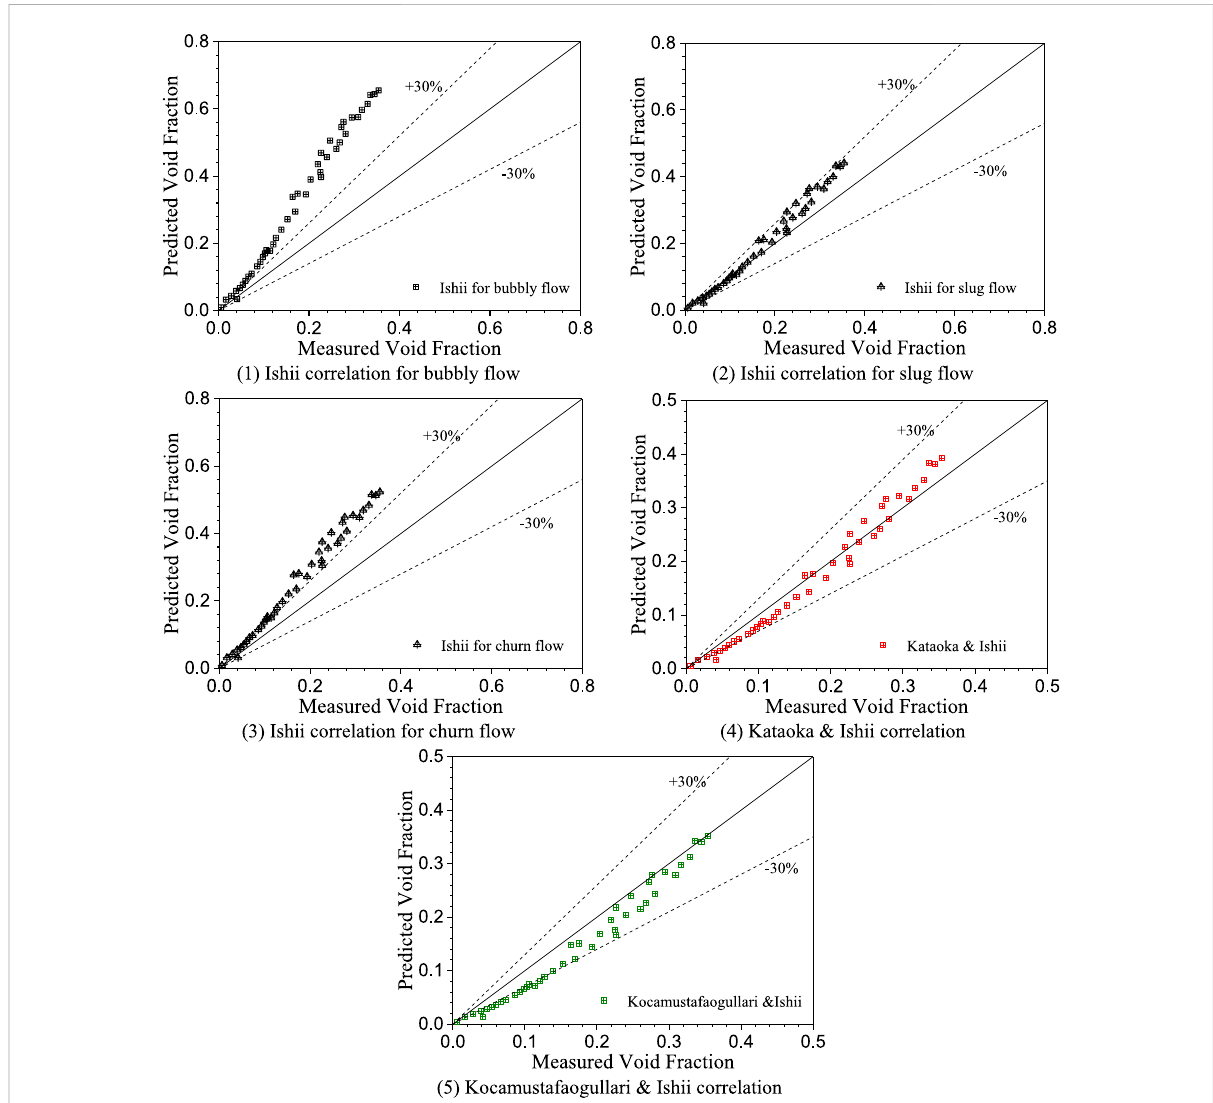
FIGURE 6 Comparisons between the measured (Saito-H 2 O experiment) and predicted void fraction. (A) Ishii correlation for bubbly fl ow. (B) Ishii correlation for slug fl ow. (C) Ishii correlation for churn fl ow. (D) Kataoka and Ishii correlation. (E) Kocamustafaogullari and Ishii